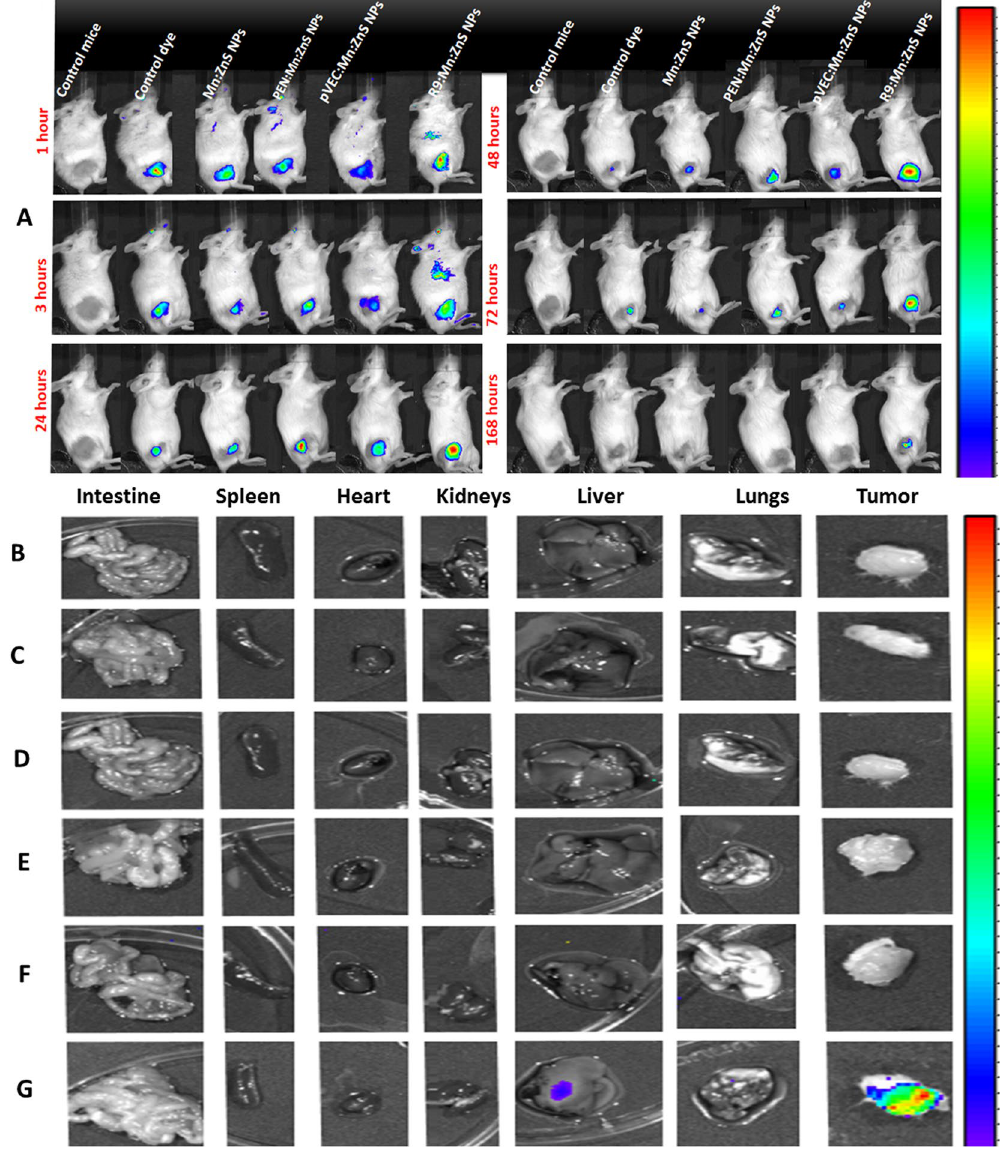
Figure 6. Bio-distribution analysis of IR-780 doped samples on 4T1 tumor model. Left to right samples: Control mice, control dye, IR-780:Mn:ZnS NPs, IR-780:PEN/Mn:ZnS NPs, IR-780:pVEC/Mn:ZnS NPs, IR- 780:R9/Mn:ZnS NPs respectively from 1 hour to 168 h. ( B – G ) shows tumor vs organ ex vivo bio-imaging on 4T1 tumor model one week after i.v injection. ( B ) Control mice; ( C ) control dye; ( D ) IR-780:Mn:ZnS NPs; ( E ) IR- 780:PEN/Mn:ZnS NPs, ( F ) IR-780:pVEC/Mn:ZnS NPs, ( G )IR-780:R9/Mn:ZnS NPs